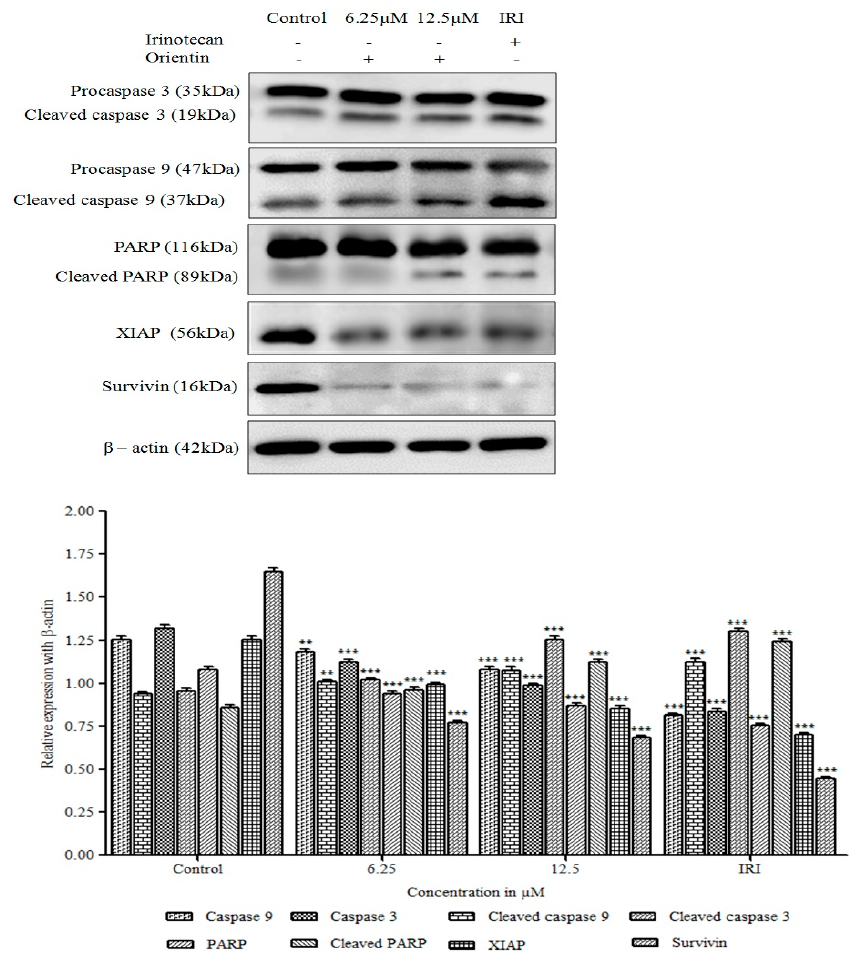
Figure 10. Effect of orientin on caspase cascade and PARP cleavage. HT29 cells treated with orientin activates caspase cascade and subsequently induces PARP cleavage. A marked reduction was observed in the expression of X-linked inhibitor of apoptotic proteins (XIAP) and survivin after treatment with orientin. β -actin was used as an internal control. Quantitative expression of proteins has shown after normalization to β -actin. Values are represented as the mean ± SD of three independent experiments (* p < 0.05, ** p < 0.01 and *** p < 0.001 vs. control).